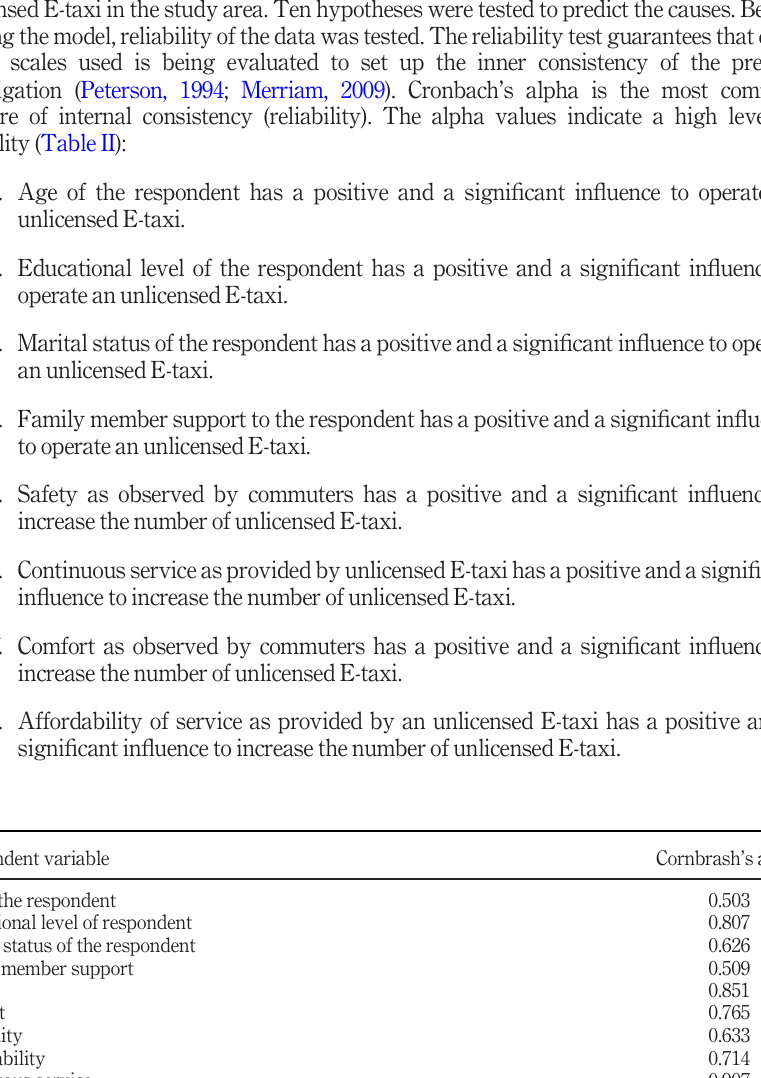
Table II. Reliability test